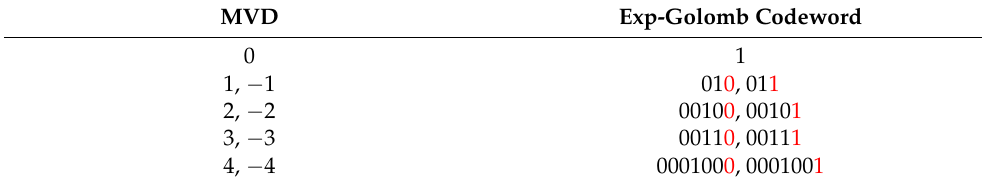
Table 1. Exp-Golomb codeword of MVD.